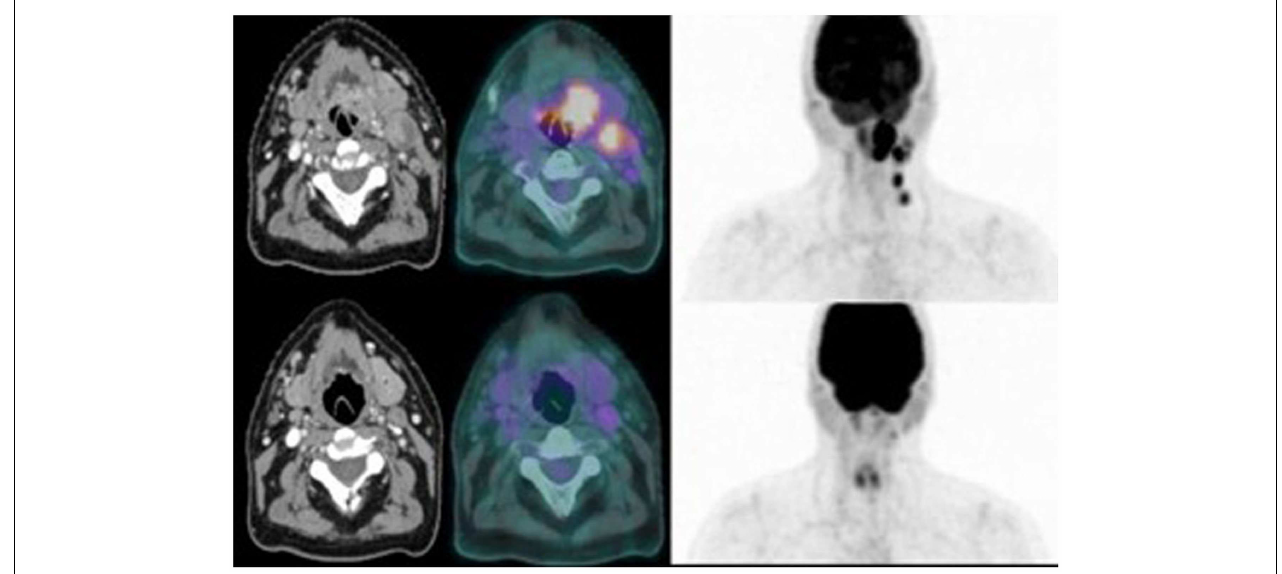
FIGURE 1 | Comparative axial images from contrast-enhanced CT (left), and 18 F-FDG-PET/CT (right) for a patient withT2N2b SCC tonsil before (top) and after (bottom) induction chemotherapy.